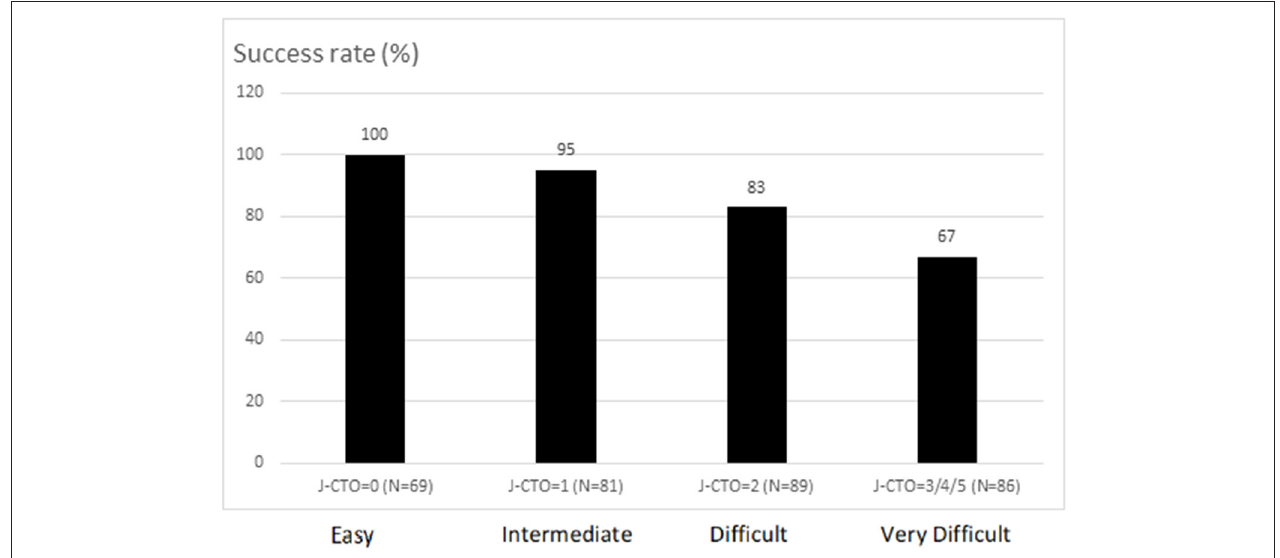
FIGURE 2 | The success rate of pure antegrade wiring-based chronic total occlusion (CTO) recanalization for each category according to Multicenter Chronic Total Occlusion Registry of Japan (J-CTO) score.